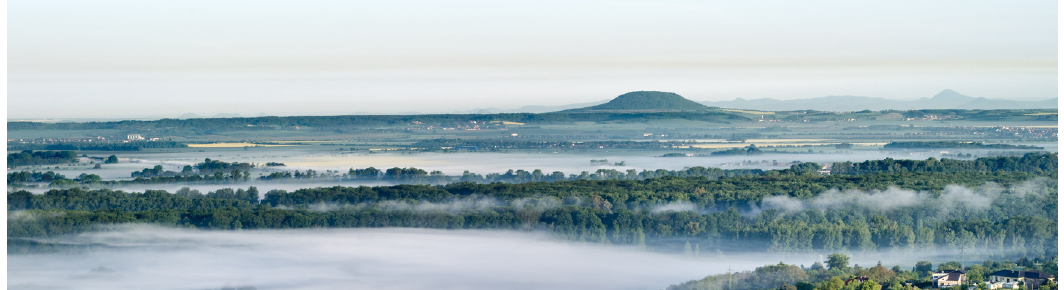
Figure 7: The Ř íp Mount, a mythical landmark of prehistoric ritual landscape in Bohemia ( view from the Elbe and Vltava con fl uence in M ě lník, photograph by Ji ř í Jirou š ek )